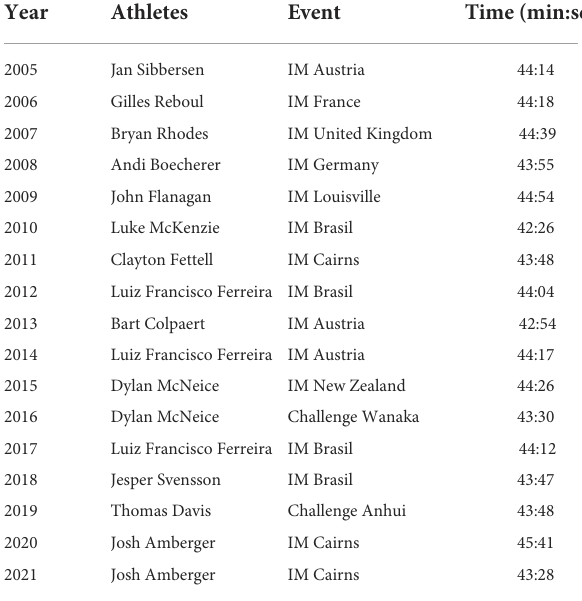
TABLE 5 Yearly fastest swimming times in an Ironman TM between 2005 to